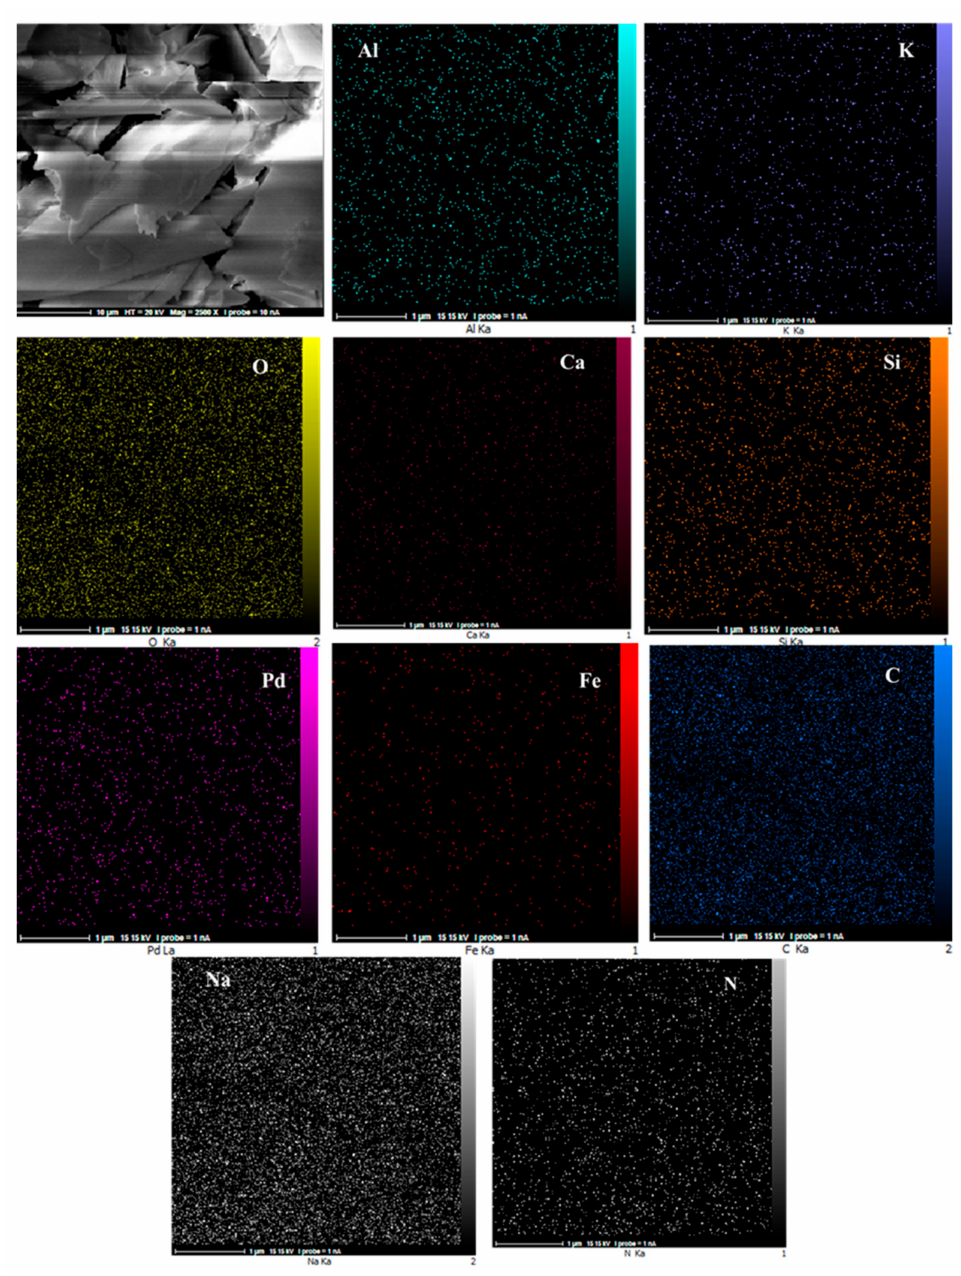
Figure 4. Elemental mapping analysis of